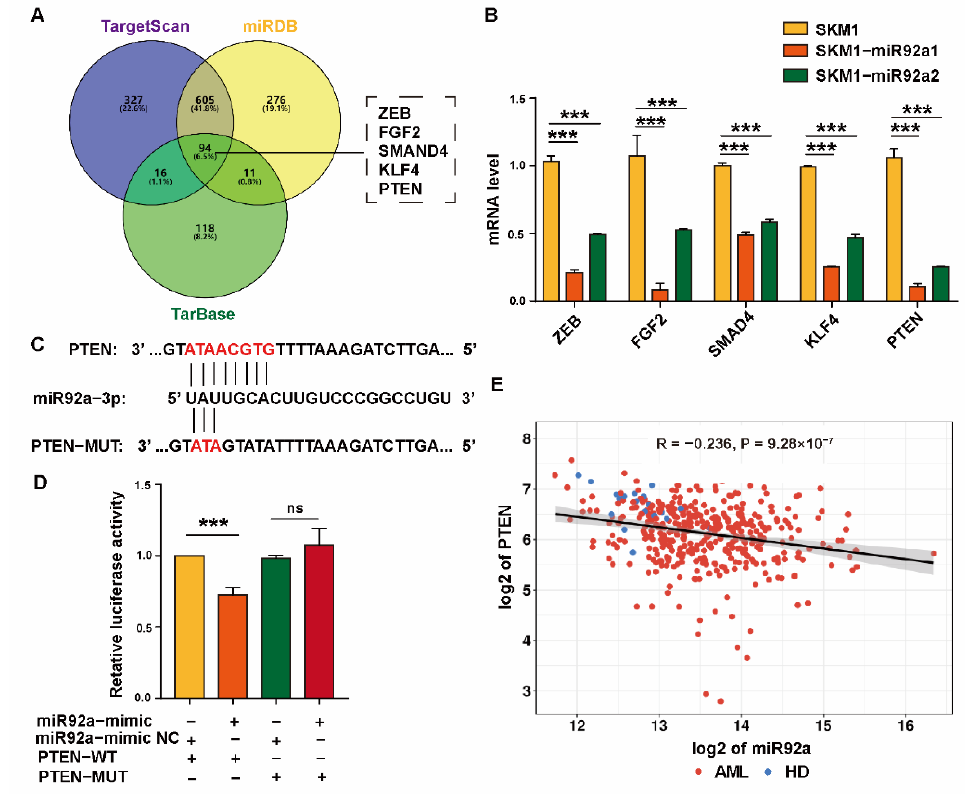
Figure 3. miR92a modulates PTEN expression. ( A ) Venn diagram of miR92a target genes predicted by three databases (TargetScan, miRDB and TarBase). ( B ) mRNA level of potential target genes in SKM1 treated by Exos-SKM1 and Exos-miR92a1/2. ( C ) The putative miR92a binding sites on WT sequence and mutant sequence of PTEN 3 (cid:48) -UTR. ( D ) HEK-293T cells were cotransfected with miR92a mimic or mimic-NC and two reporter plasmids psiCHECK2 (WT or mutant PTEN 3 (cid:48) -UTR sequence), and luciferase activities of transfected cells were assayed. ( E ) Correlation of expression of miR92a and PTEN in AML ( n = 207) and healthy donors ( n = 18), ns ≥ 0.05, *** p <